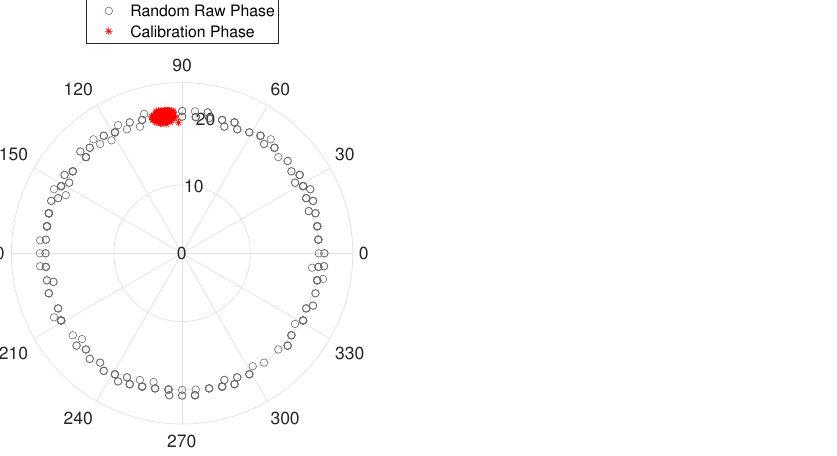
Figure 3. Phase offsets are removed by using the calibration algorithm. In polar coordinates, the phase of the raw signal exhibits a random distribution. After calibration, the real phase shift is